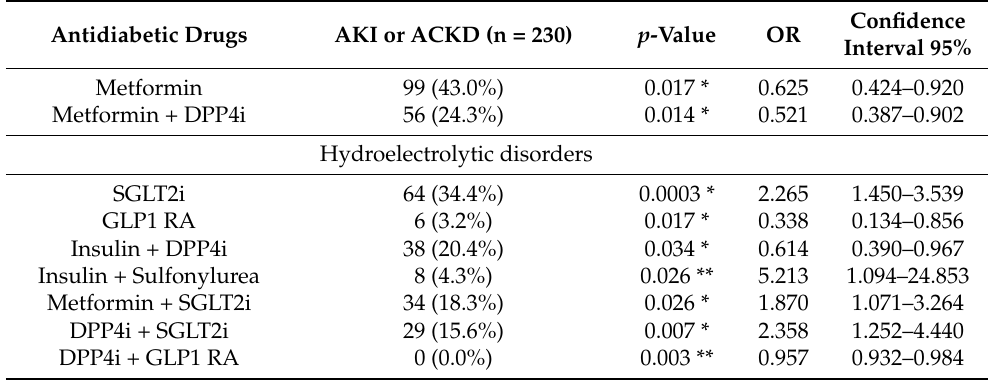
Table 4. Relationship between antidiabetic therapy and acute kidney injury, acute chronic kidney injury, and hydroelectrolytic disorders.